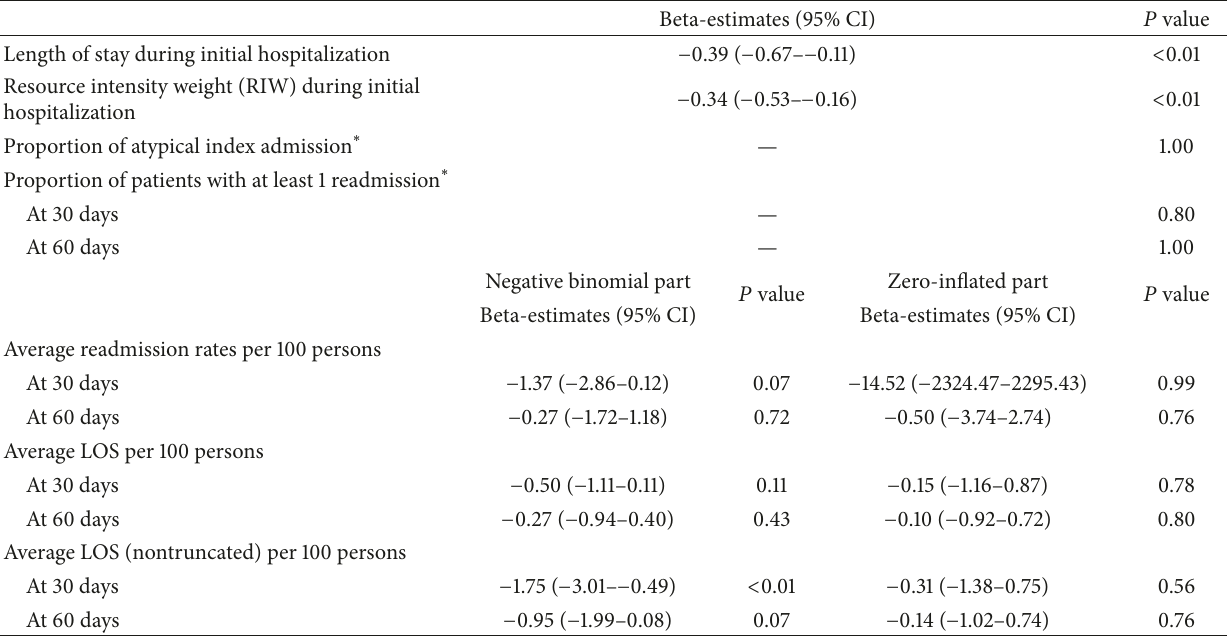
Table 4: Results of the statistical comparisons of the outcomes within the matched